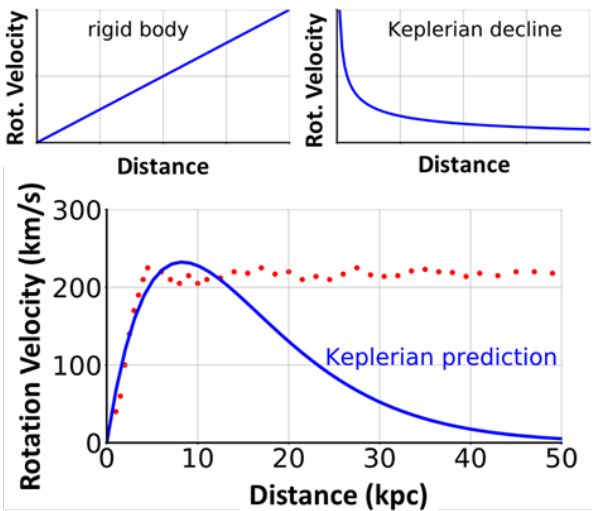
Figure 2. Rotational speed for a rigid body (top left) and for Keplerian motion, e.g., our solar system, with most of the mass centred at zero (top right). Below, the result (red dots) for a typical spiral galaxy is shown. The disagreement of the rotational speed of galaxies from the Keplerian prediction for R > 10 kpc (i.e., the constant speed) was first observed by F. Zwicky [23,24] in the 1930s in the Coma Cluster, and indicates that more mass than visible must be present.